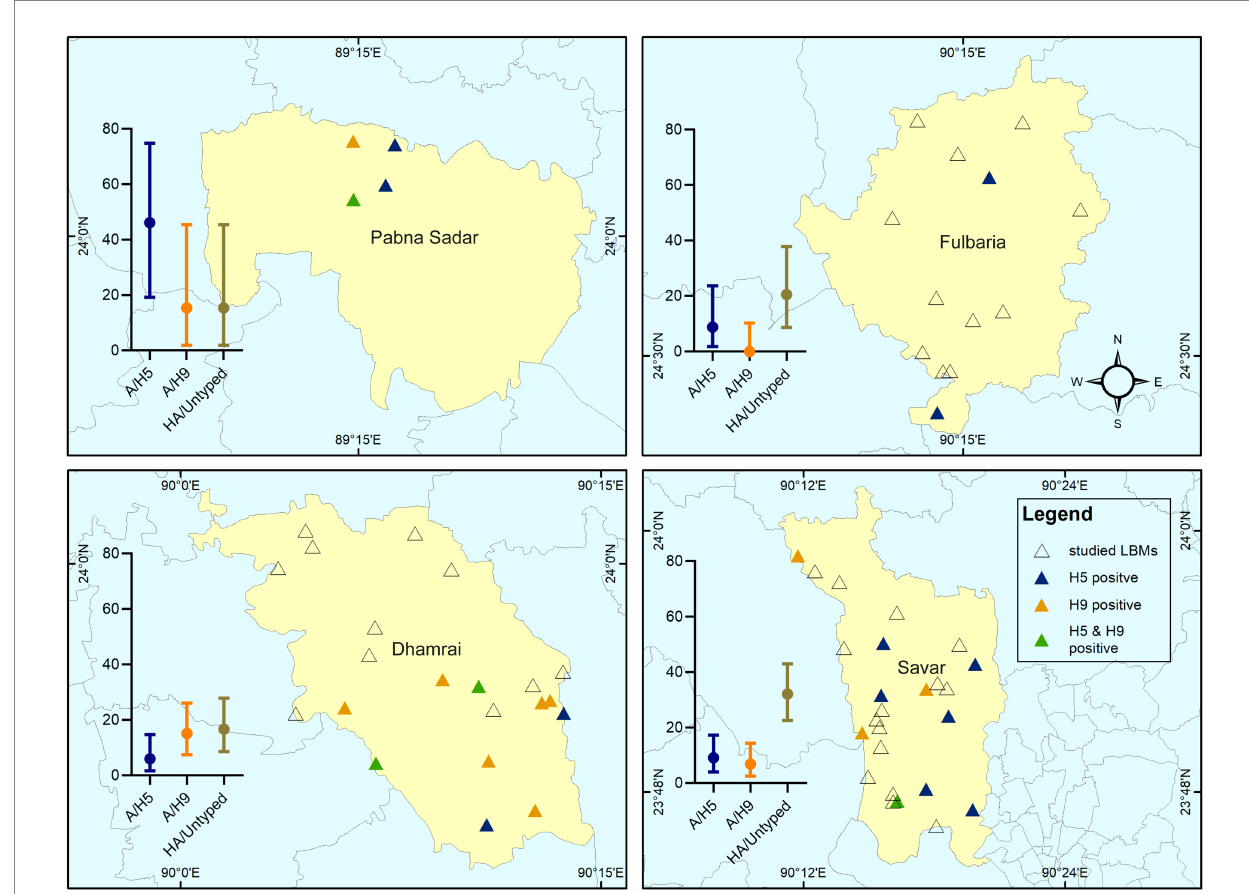
FIGURE 2 Spatial distribution of studied LBMs and the prevalence of H5, H9, and A/HA untyped detected in the LBMs. The error bar with mean value indicates the prevalence of subtypes of AIV at stall level in that region.